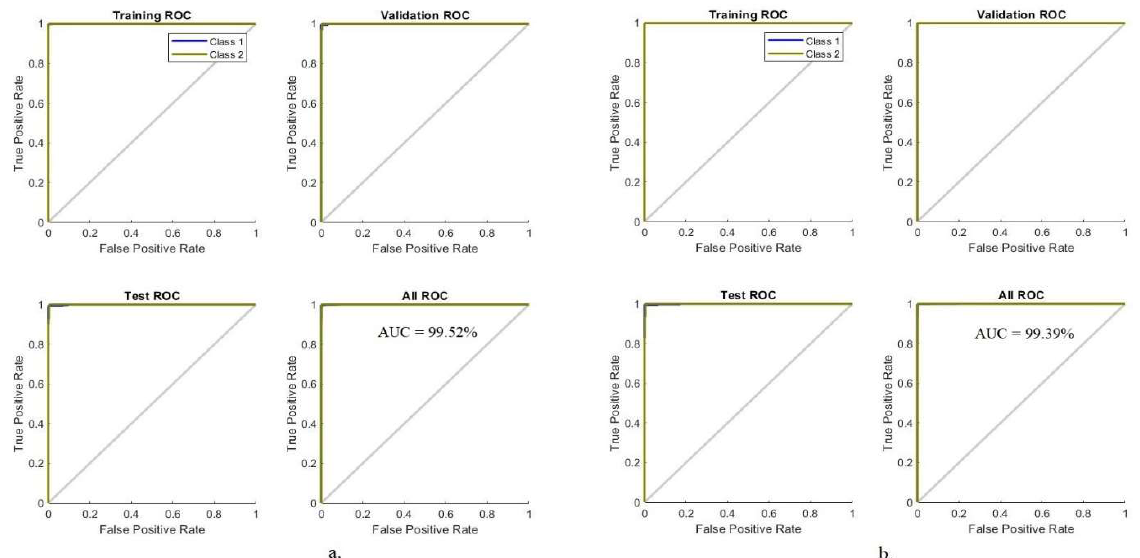
Figure 10. ROC for evaluating ANN performance based on hybrid features. ( a ) AlexNet, DWT, LBP, FCH, and GLCM; ( b ) ResNet-18, DWT, LBP, FCH, and GLCM. FCH, and GLCM; ( b ) ResNet-18, DWT, LBP, FCH, and